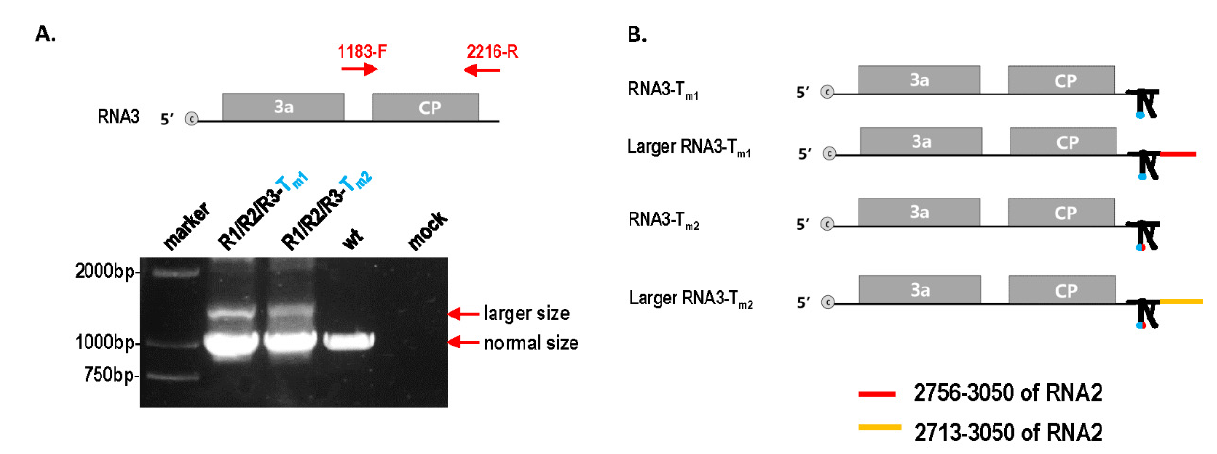
Figure 2. Identification of large size RNA3 in R1/R2/R3-T m1 and R1/R2/R3-T m2 . ( A ) RT-PCR of posi- tion 1183–2216 in RNA3; 1183-F and 2216-R indicate the forward and reverse primers. ( B ) Schematic diagram of large RNA3 in R1/R2/R3-T m1 and R1/R2/R3-T m2 .